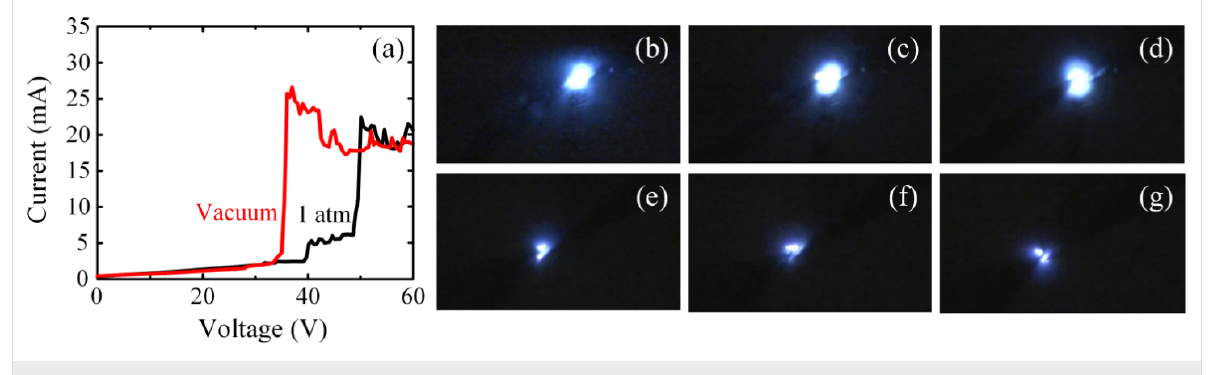
Figure 9: (a) I – V characteristics for two DC voltage sweep measurements from 0–60 V performed in vacuum (red) and at atmospheric pressure (black). These measurements were performed on ZnO nanorods grown on two different polysilicon microstructures of very similar dimensions. (b–g) Video frames extracted from a high-resolution camera recording for the corresponding light emission for the DC measurements at atmospheric pressure (b–d) and in vacuum